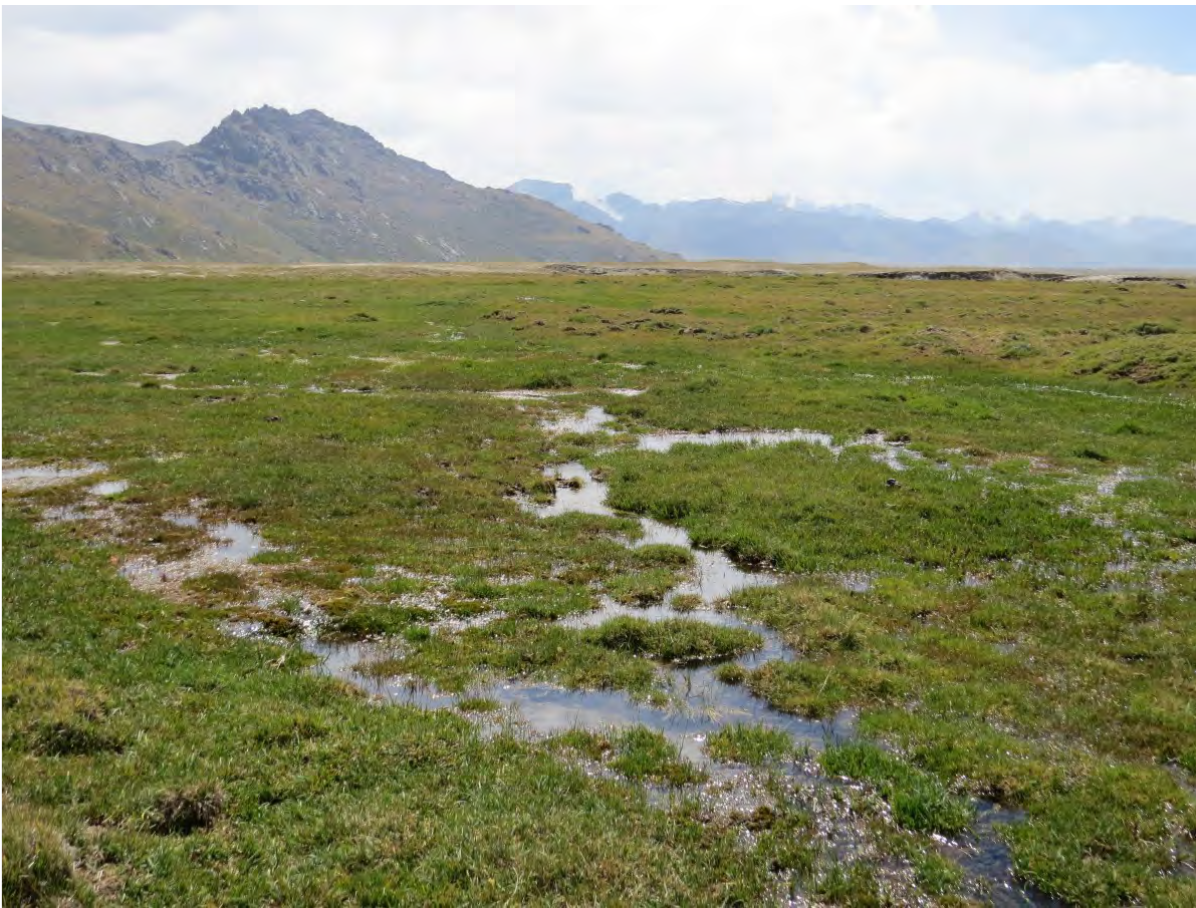
Figure 5. Photograph of the Čatyr-Kël' Peatland (photo Thomas